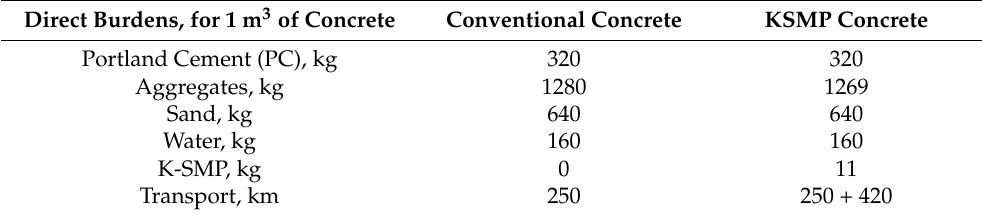
Table 1. Input to the inventory analysis for the conventional concrete and kSMP concrete.